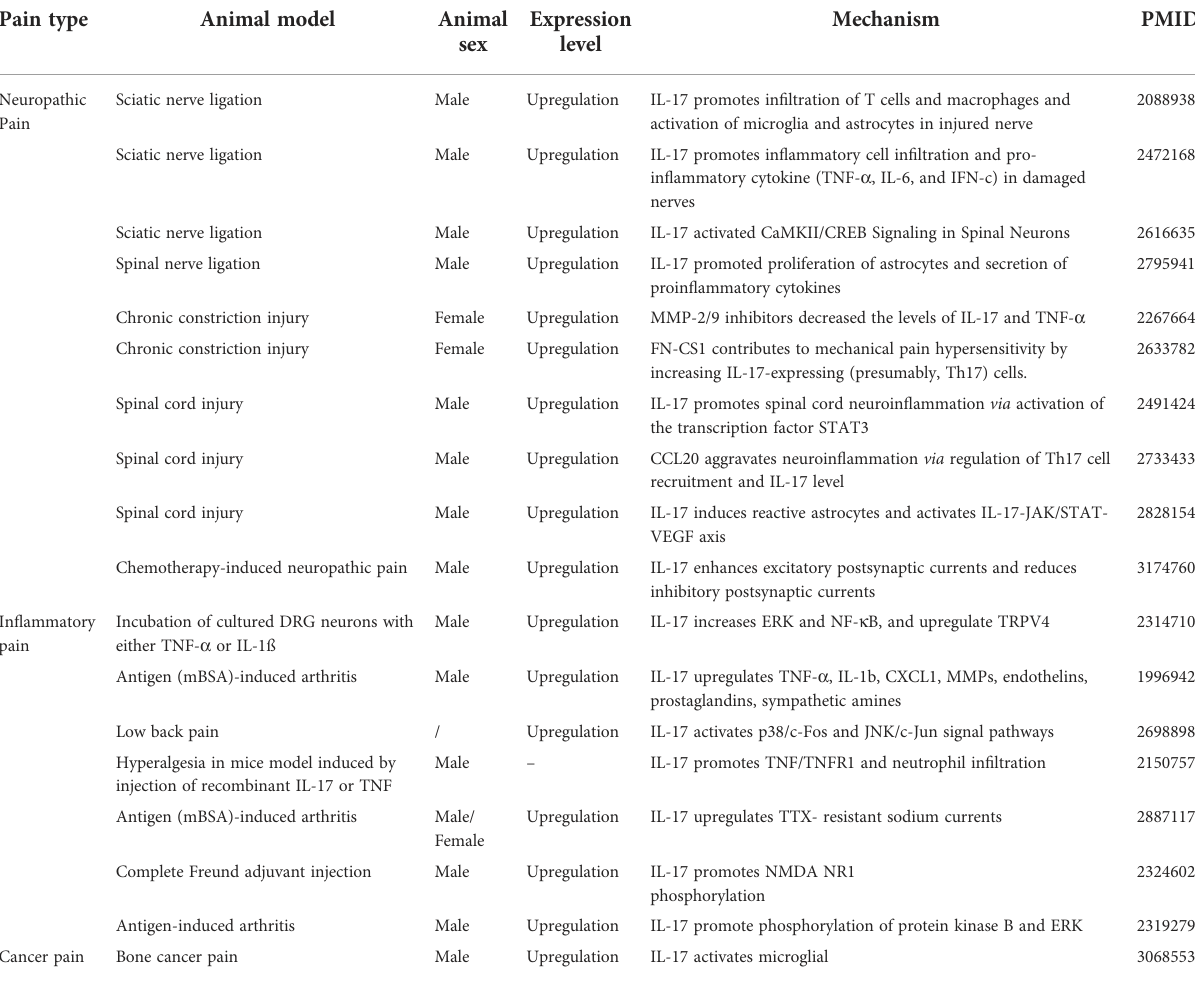
TABLE 1 Summary of characteristics of studies on the role of IL-17 in chronic